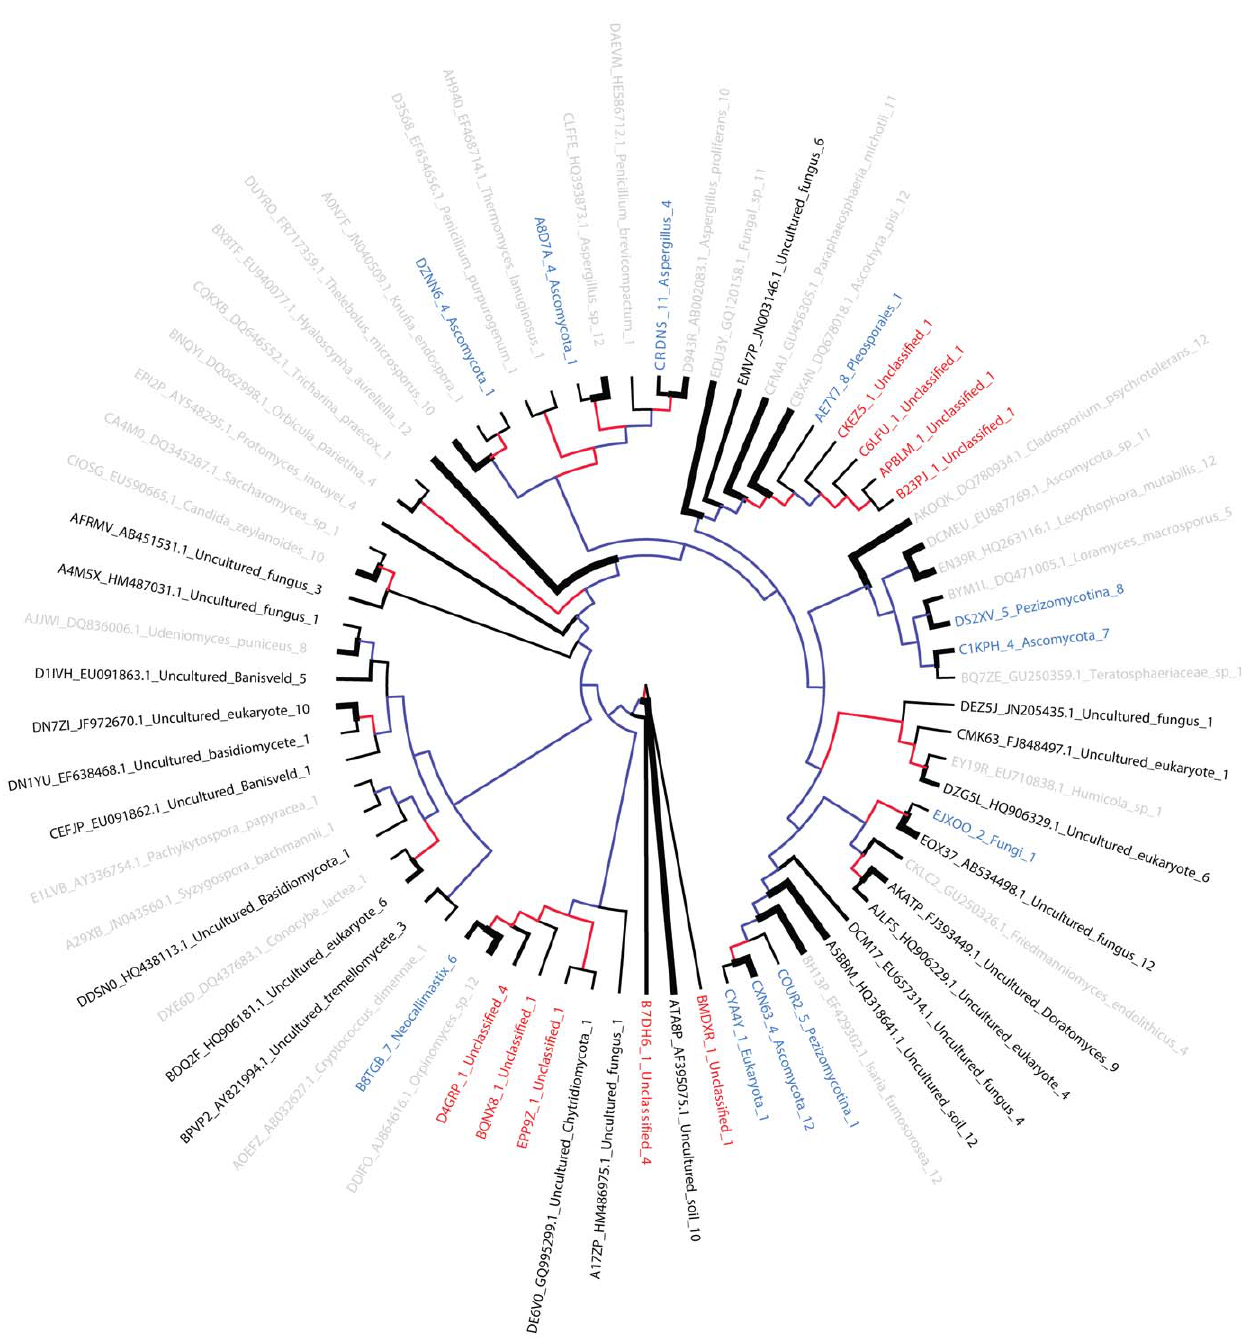
Figure 5. Phylogenetic diversity of fungal 18S rRNA sequences in bovine rumen. NJ tree clustering of OTU representatives labeled based on similarity to known sequences. The color of the branch indicates bootstrapping value: blue when bootstrapping was , 50%, red when bootstrapping was . 50%. The width of the branch is proportional to the number of animals (1–12) that exhibited a given OTU. This number of animals is also indicated in the last part of the OTU label. Gray- and black-labeled OTUs were classified using BLAST and at least 97% identity to a target sequence. Black labels highlight a subset of these OTUs with vague annotation. OTUs labeled in blue did not match a target using BLAST, but were subsequently classified using LCA based on 90% identity to a SILVA database match. OTUs in red failed both BLAST and LCA and are presumably novel taxa.